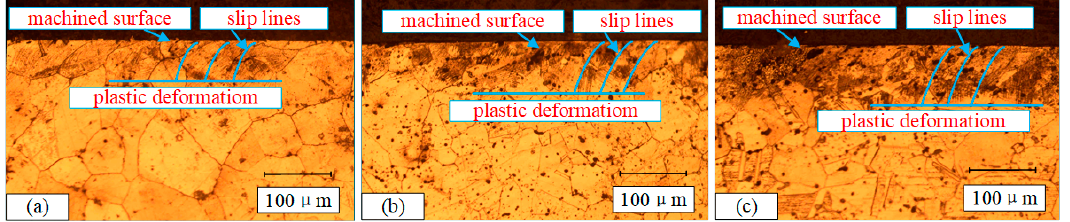
Figure 11. Microstructure micrograph close to the surface layer at different cutting speeds. ( a ) sample 2, ( b ) sample 5, ( c ) sample 8.